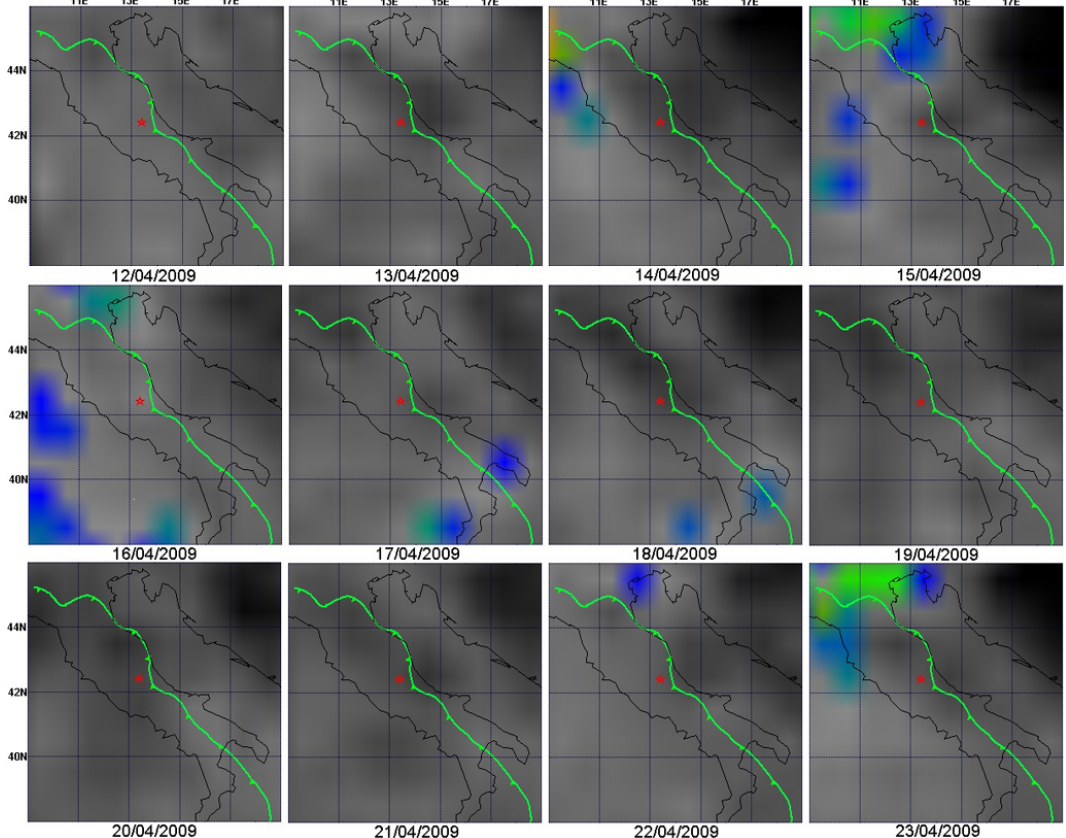
Fig. 6. Spatial-time evolution of the temperature changing based on the NCEP data (all at 00:00UTC) in the cycle “D”.